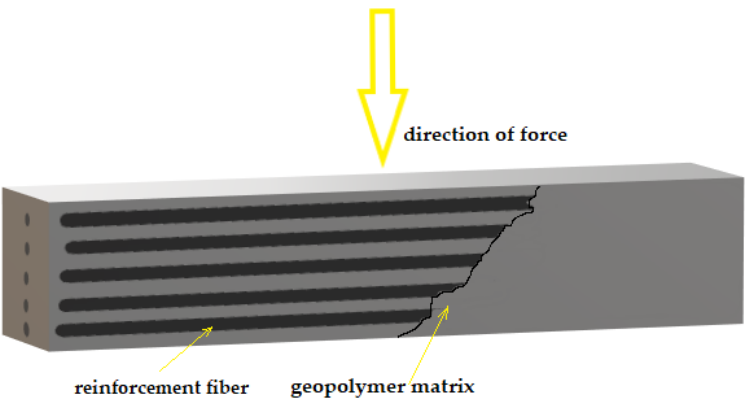
Figure 8. Method of testing for compressive strength.